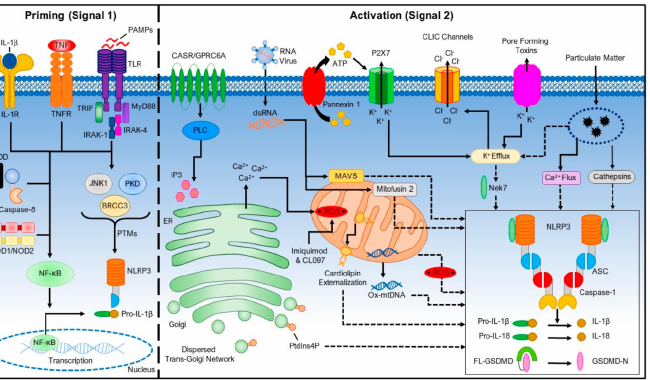
Figure 1. Pathways for NLRP3 inflammasome activation, illustrating priming ( left ) and activation ( right ). The interaction of particulate matter with these pathways is included in the upper-right corner (reproduced from Kelley et al., 2019